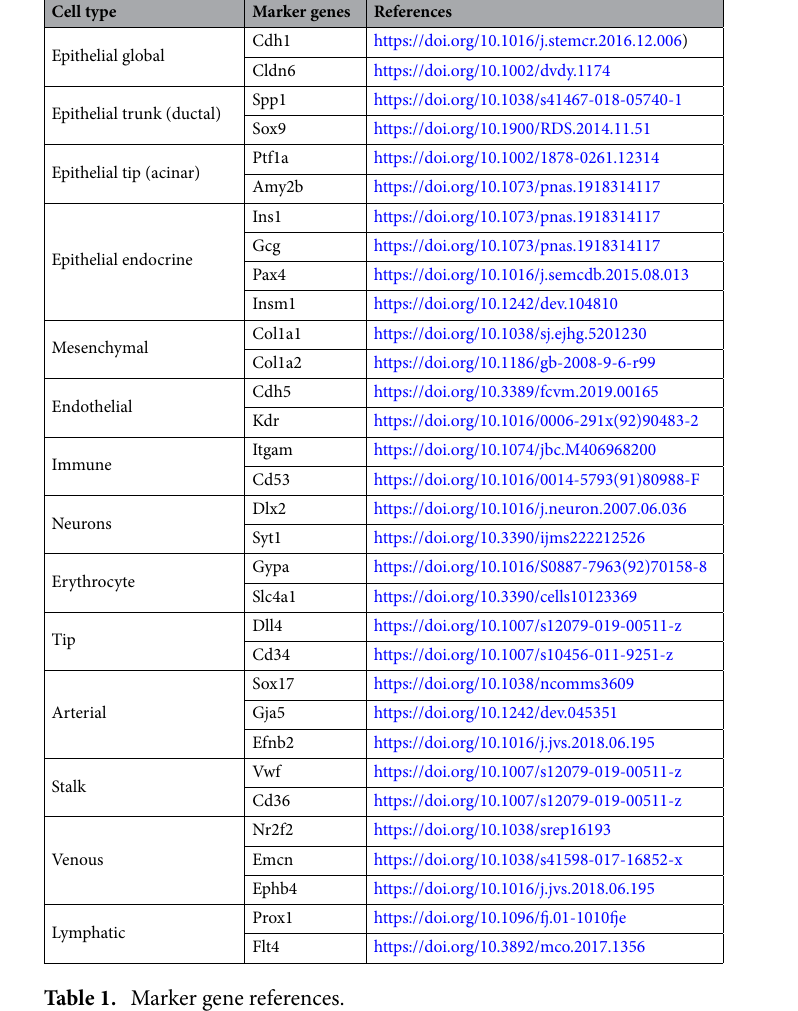
Table 1. Marker gene